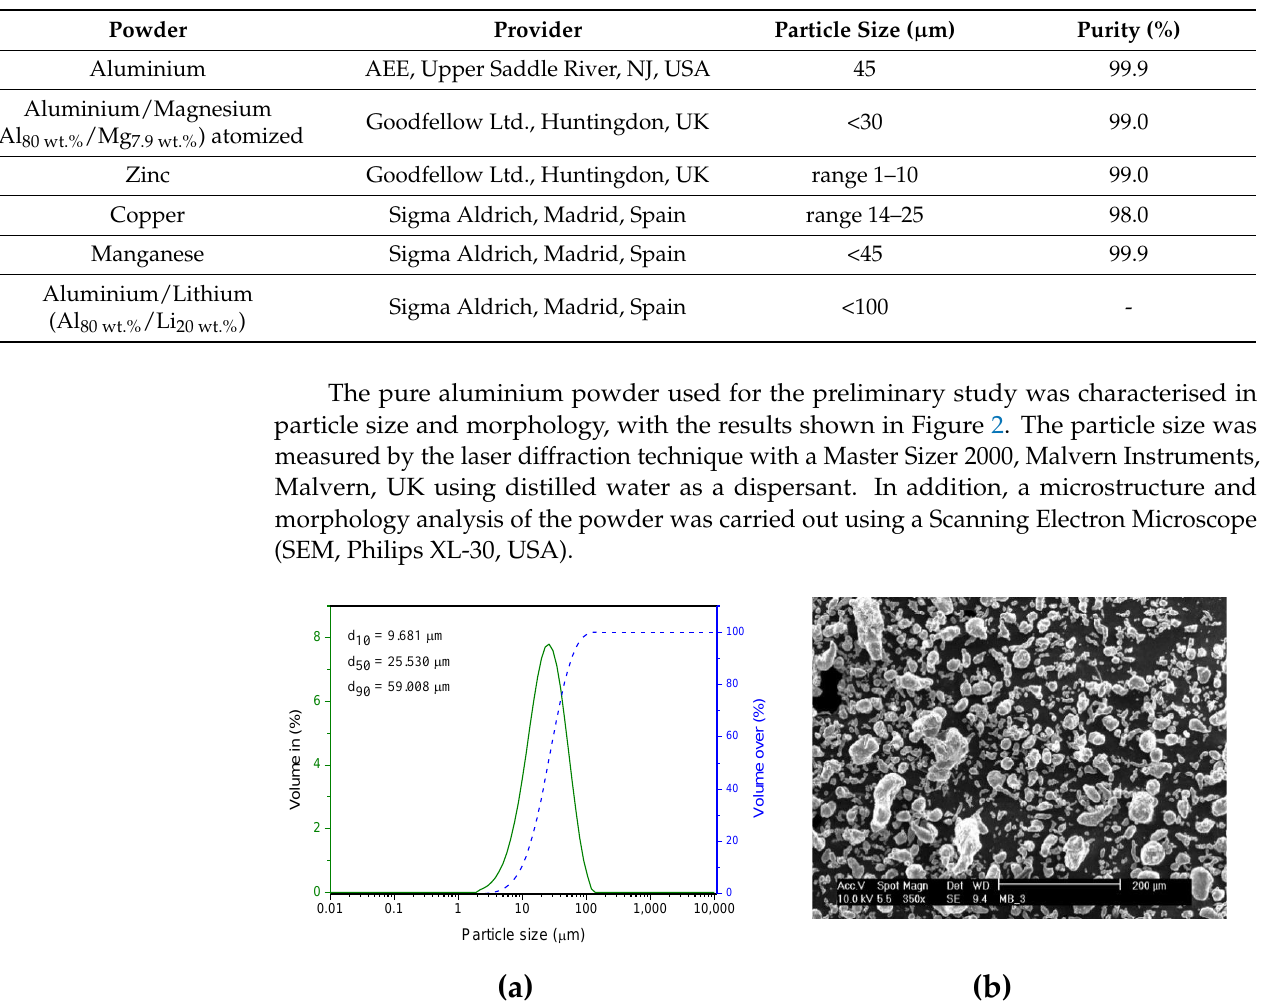
Table 1. Characteristics of powders. Aluminium and alloying elements.